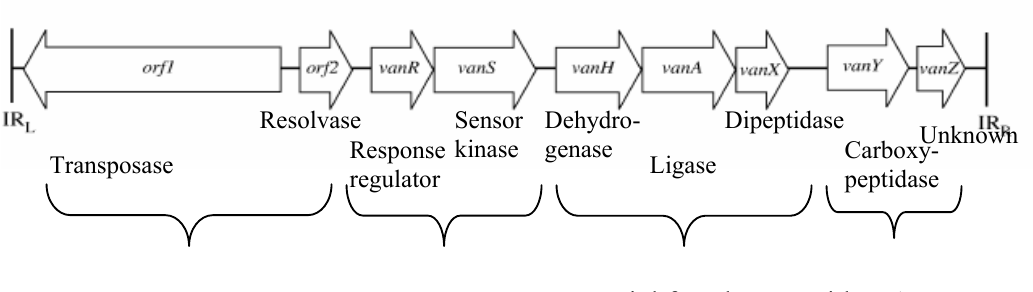
Figure 3. Genetic map of Tn l546 transposon